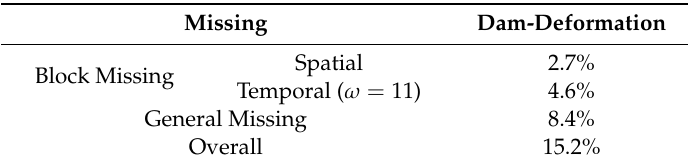
Table 1. Statistics on missing values in experimental